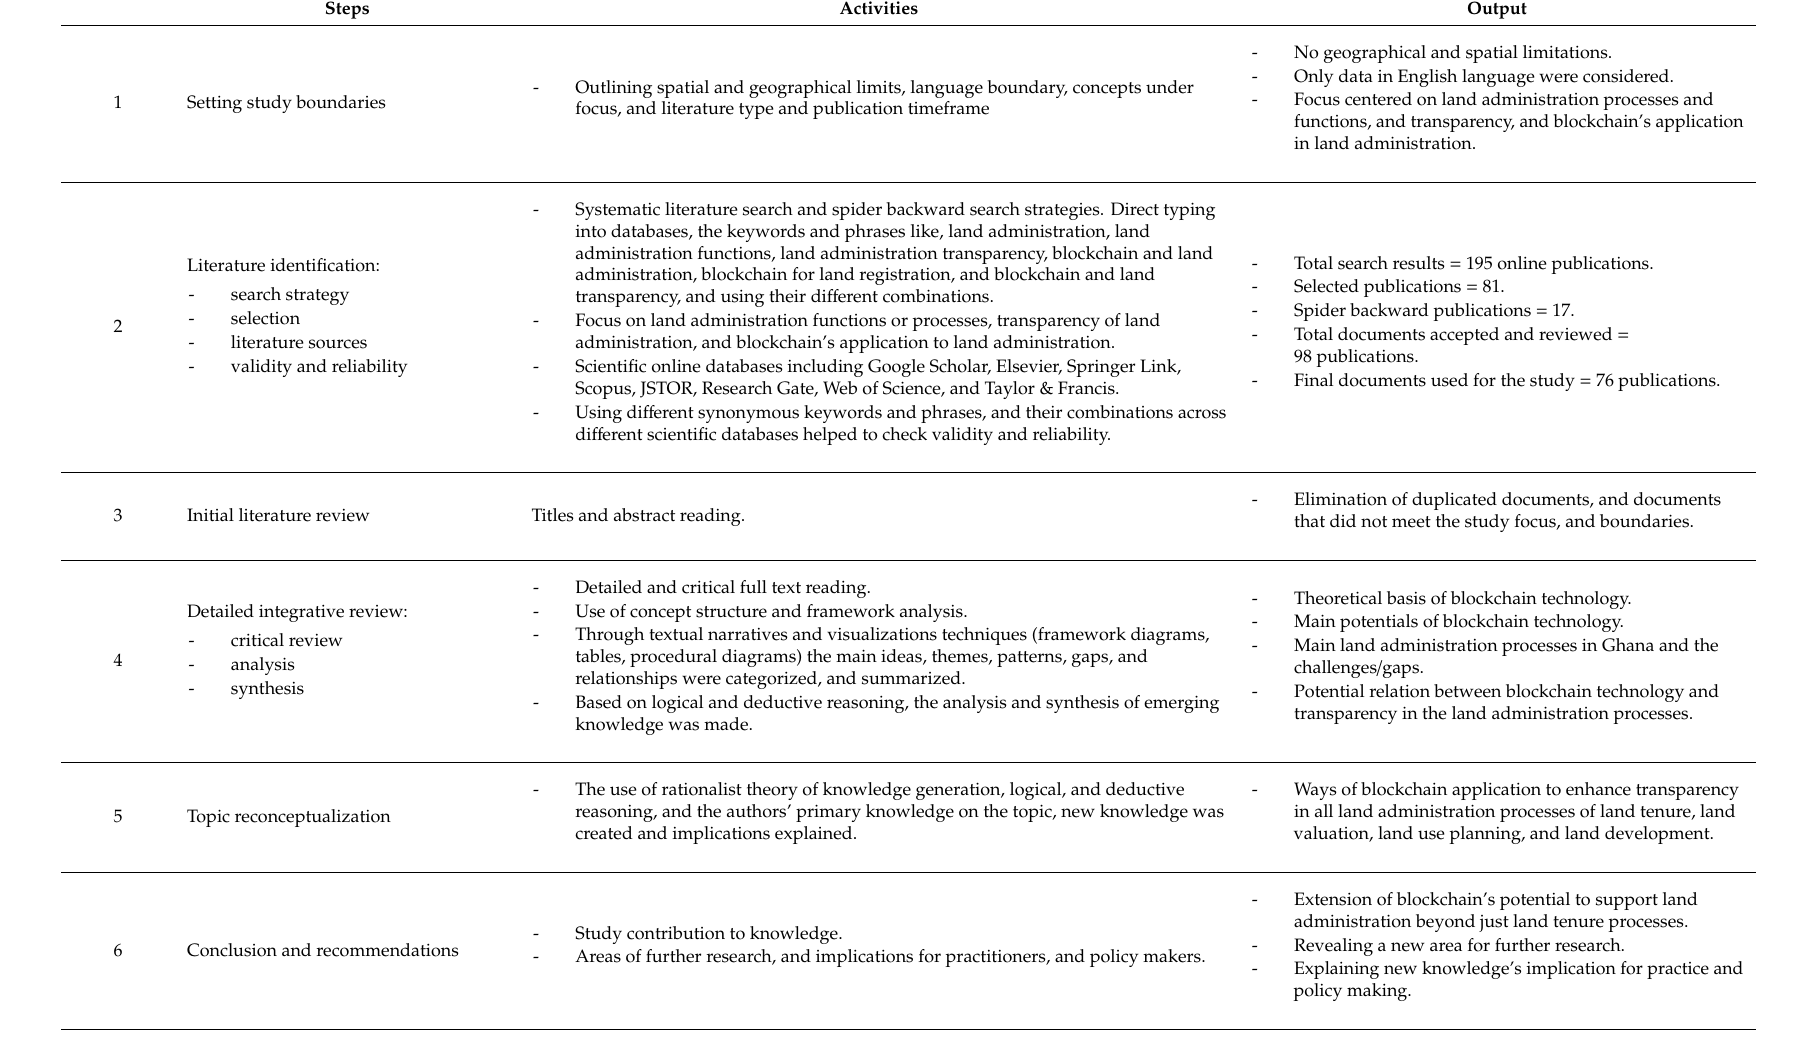
Table 1. Research process and design